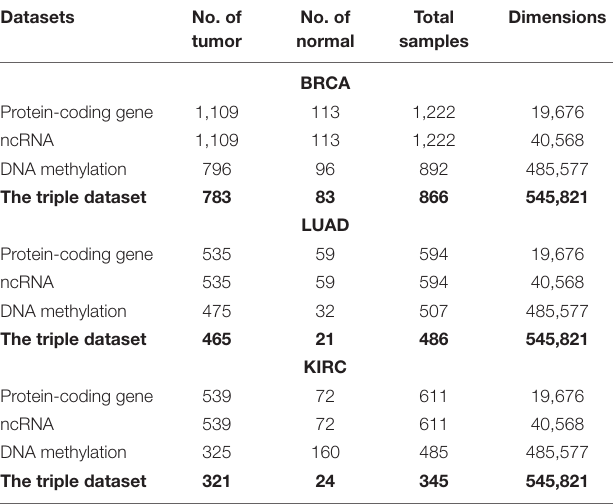
TABLE 1 | Summary of the original different datasets for three cancers. Datasets